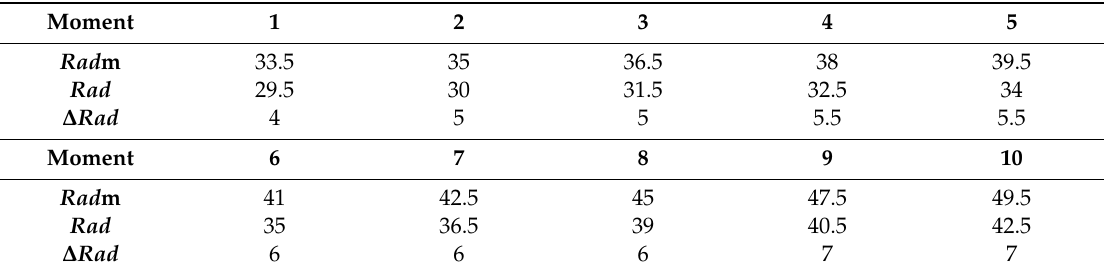
Table 11. The danger sectors of another 10 moments in a crossing encountering